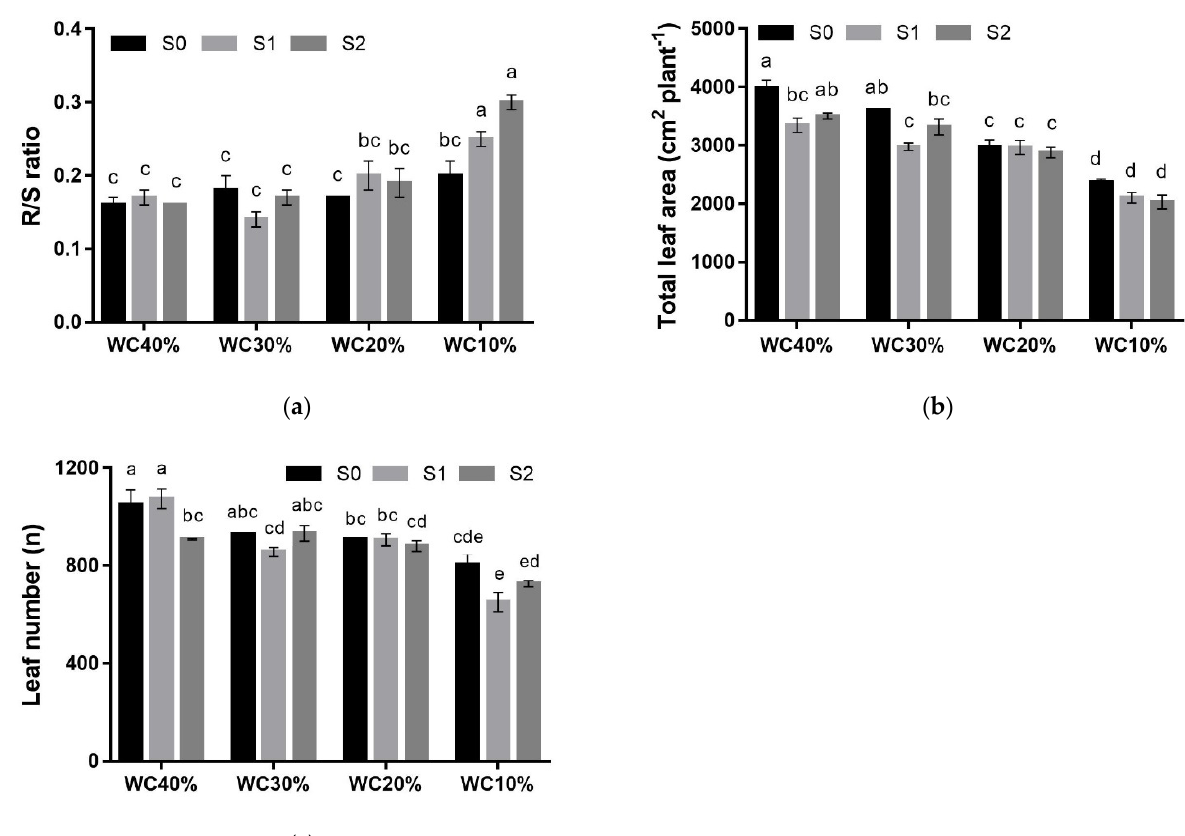
Figure 1. Interaction effect of drought (WC40%: control; WC30%: light drought stress; WC20%: moderate drought stress; WC10%: severe drought stress) × saline aerosol treatment (S0: Distilled water, S1: 50% Synthetic seawater solution, S2: 100% Synthetic seawater solution) for Callistemon plants on root to shoot ratio ( a ), total leaf area ( b ), and leaf number ( c ). Data are means ± standard error ( n = 3). Three biological replicates were used for the measurements. Data were subjected to two-way ANOVA and differences among means were determined using Tukey’s post-test. Different letters indicate statistical differences for p < 0.05.